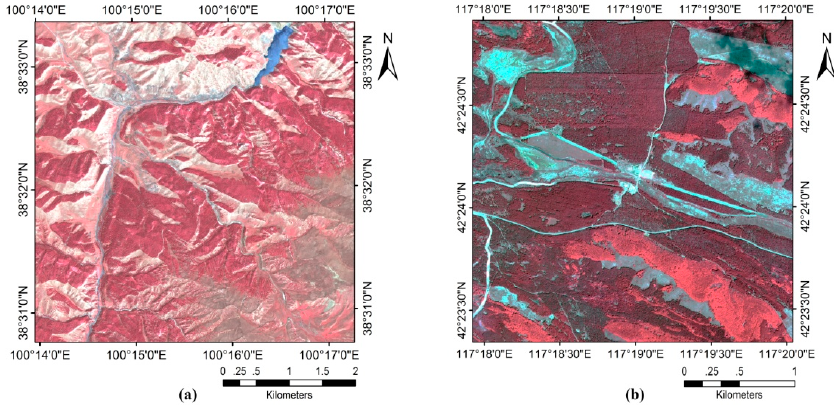
Figure 2. Images after topographic correction at Dayekou ( a ) and Saihanba ( b ). (False color composite: Red-Near infrared 1, Green-Red, Blue-Green). Red-Near infrared 1, Green-Red,